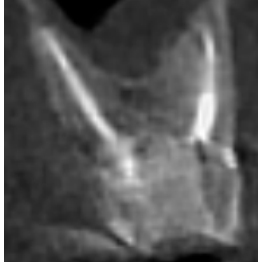
Figure 4. C—the teeth with severe caries infection.